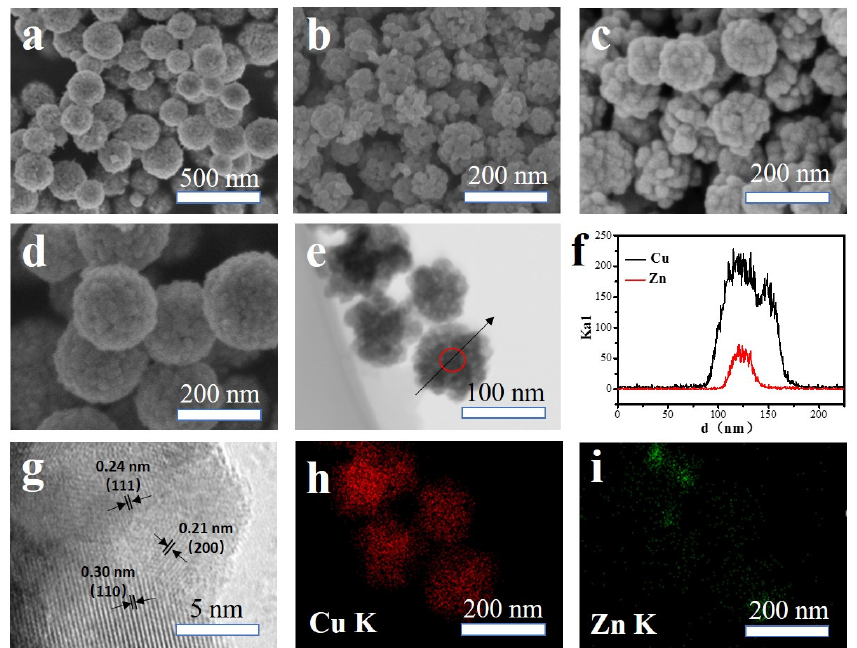
Figure 2. SEM images of ( a ) Cu 2 O, ( b ) 4ZnO@Cu 2 O, ( c ) ZnO@4Cu 2 O, and ( d ) ZnO@20Cu 2 O. ( e ) TEM image of ZnO@4Cu 2 O and ( f ) line EDX analysis along the arrow. ( g ) HR-TEM image of ZnO@4Cu 2 O. ( h ) Cu K and ( i ) Zn K mappings of ZnO@4Cu 2 O.